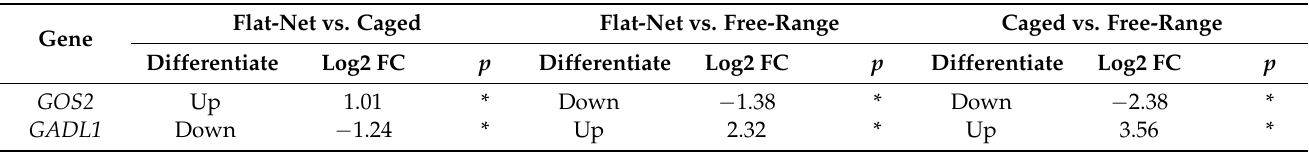
Table 4. Differential expression statistics of candidate